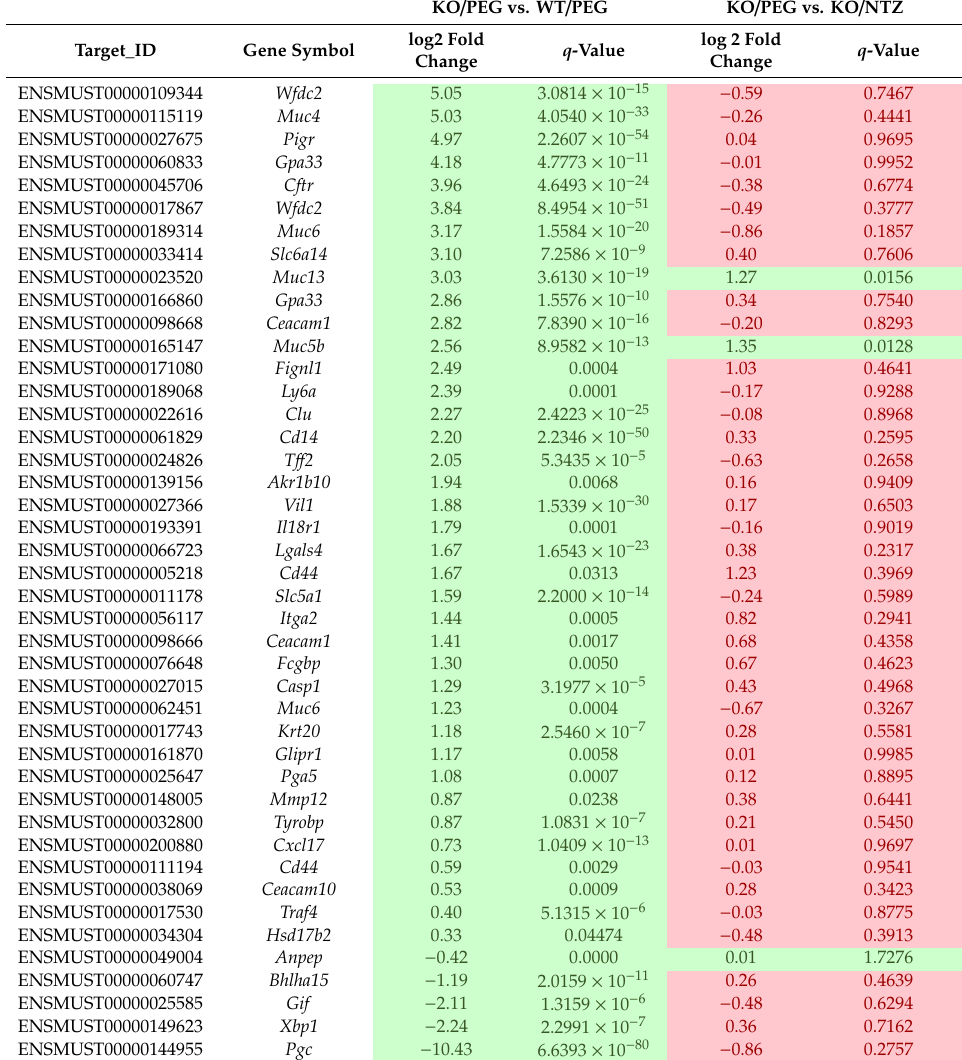
Table 2. Expression of spasmolytic polypeptide-expressing metaplasia (SPEM)-related genes in the gastric corpus mucosa of KO / PEG versus WT / PEG mice and in KO / NTZ versus KO / PEG mice. Numerous of these genes were overexpressed in KO / PEG mice, but most of these genes were not a ff ected by NTZ. Green: significant change (adjusted p-value ( q -value) < 0.05); red: non-significant change ( q -value > 0.05).